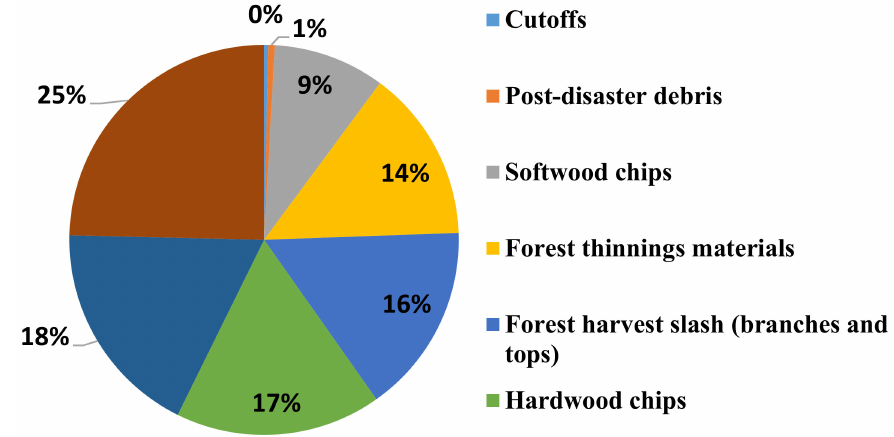
Figure 2. BCAP matching payments allocation among forestry biomass during 2009–2010. Data Source: The U.S. Department of Agriculture/Farm Service Agency, BCAP, 2010, Report of BCAP CHST payments by biomass type